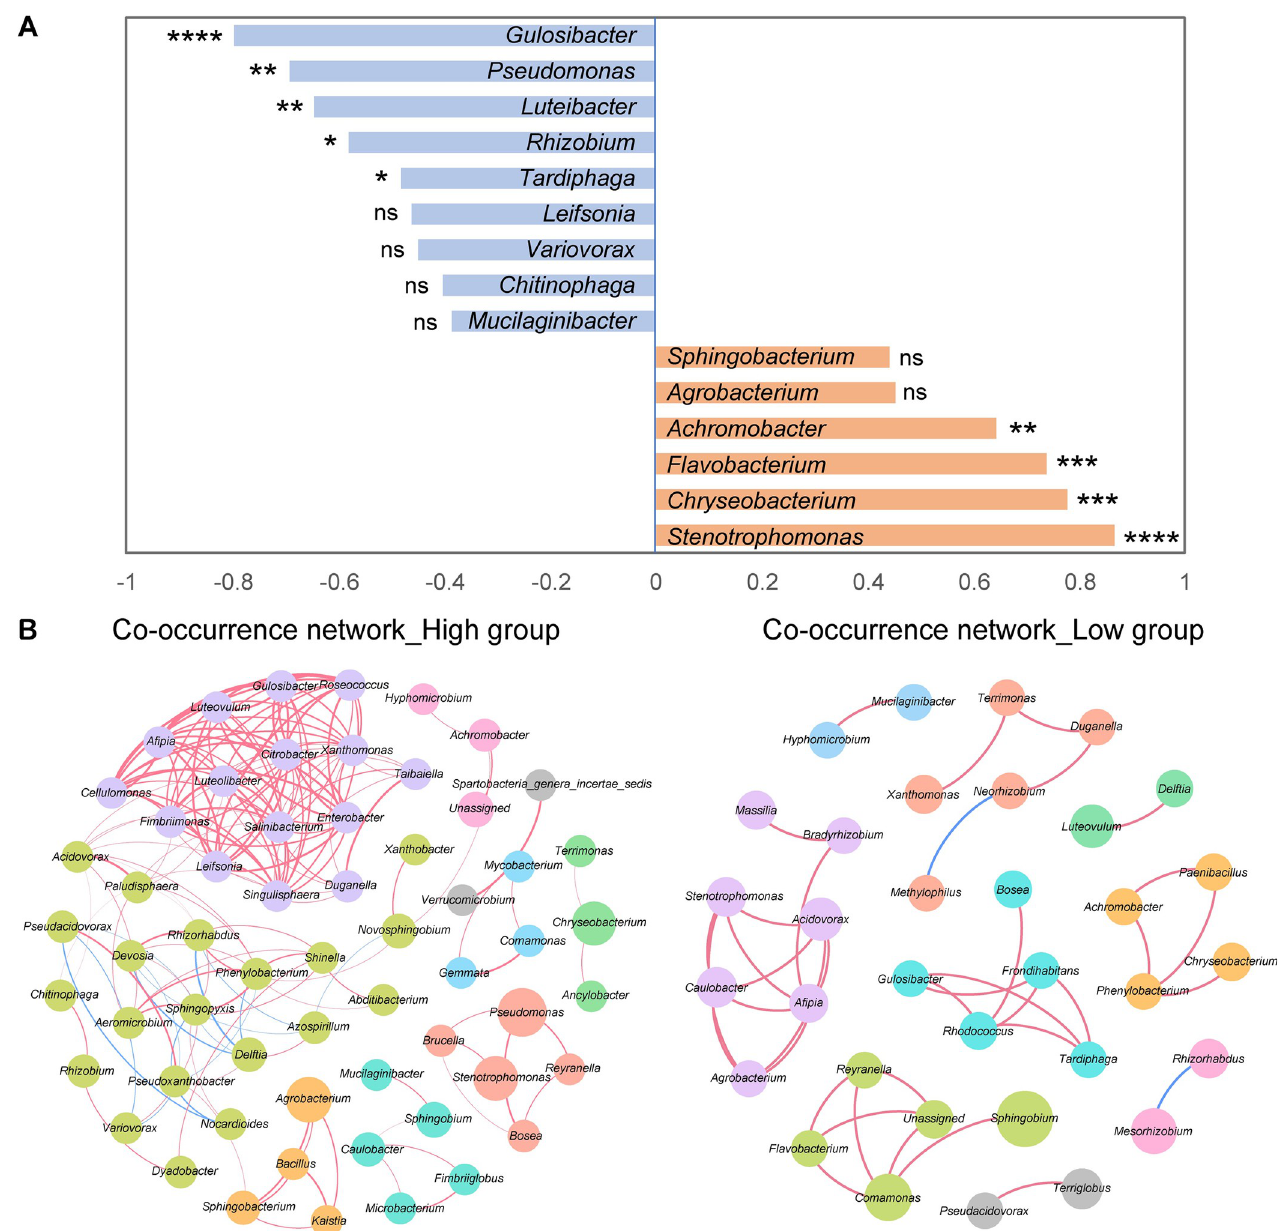
Fig 7. Bacterial genera related to the stimulation of P . brassicae resting spore germination. (A) Correlation between germination rates and relative abundance of bacteria (Spearman’s ρ , P < 0.0001 ���� ; P < 0.001 ��� ; P < 0.01 �� ; P < 0.05 � ; ns, not significant). (B) Co-occurrence network of ‘high’ and ‘low’ germination rate groups based on the Spearman correlation algorithms. Each node represents a genus and is colored by modularity. The node size indicates the relative abundance of each genus per group, and the thickness of the line represents the Spearman coefficient (R s > 0.8 or < -0.8, P < 0.01). Red links stand for positive, and blue links for negative correlations between